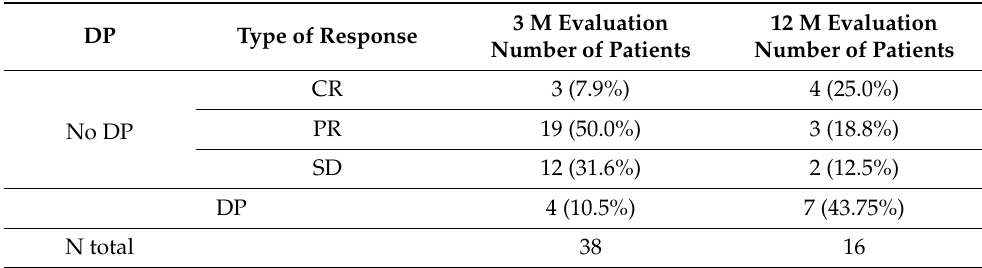
Table 6. Overall treatment response in patients with measurable disease. DP Type of Response